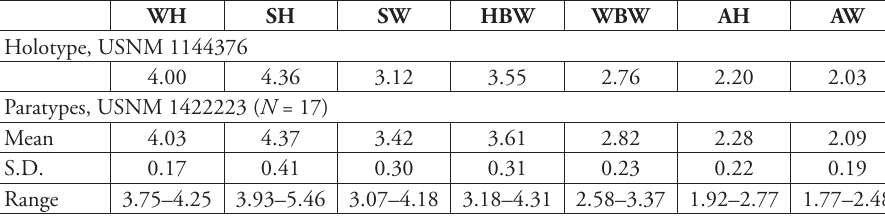
Table 1. Shell parameters for F. fresti . Measurements are in mm. WH